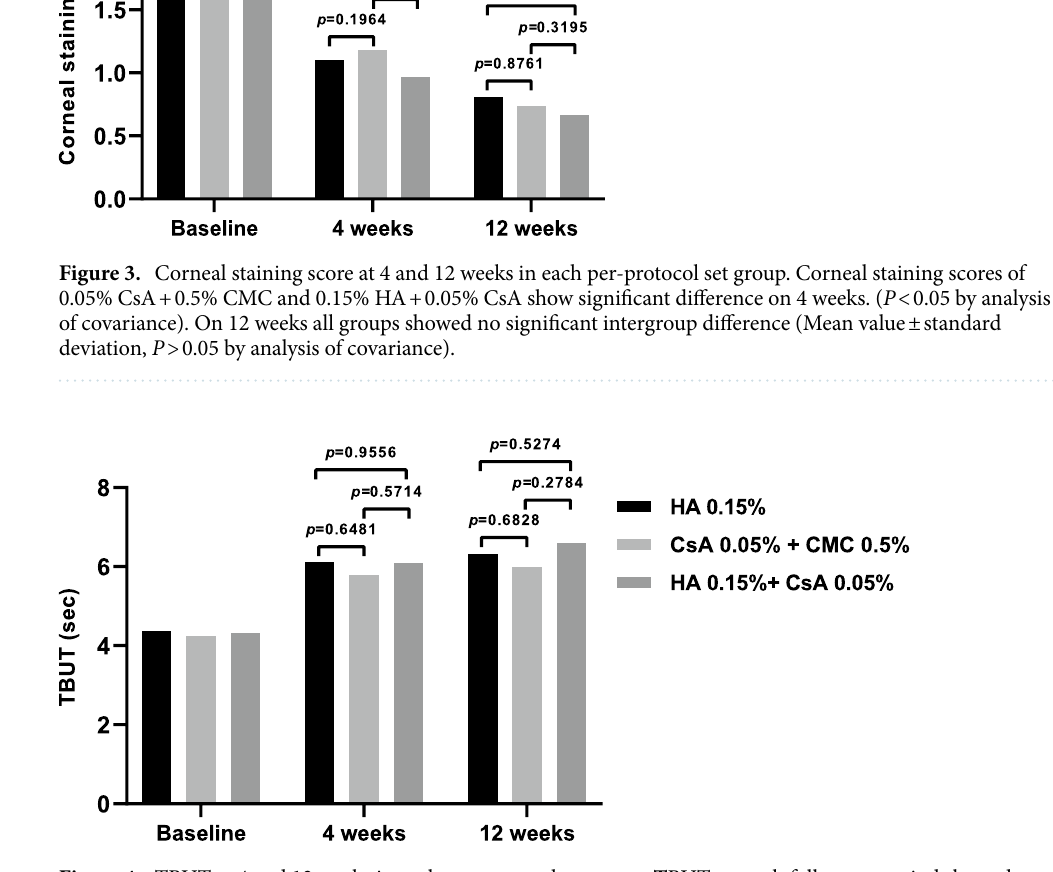
Figure 4. TBUT at 4 and 12 weeks in each per-protocol set group. T BUT on each follow-up period showed no significant intergroup difference (Mean value ± standard deviation, P > 0.05 by analysis of covariance).